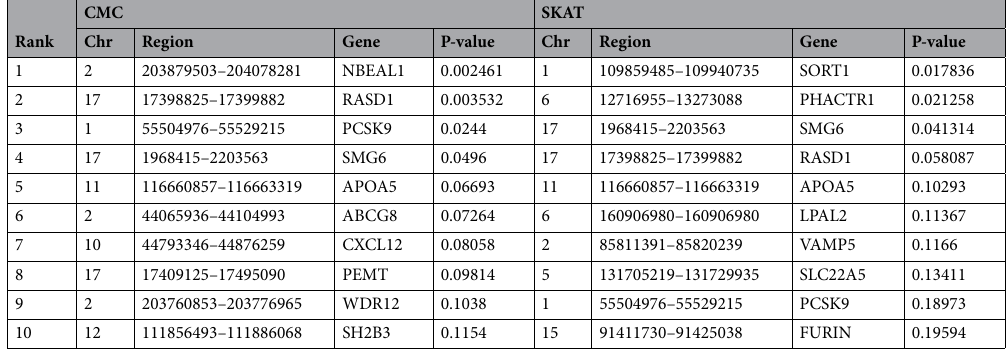
Table 5. Top genes from gene-based analysis (CMC and SKAT) of low frequency and rare variants (MAF < 0.05) for CAD GWAS